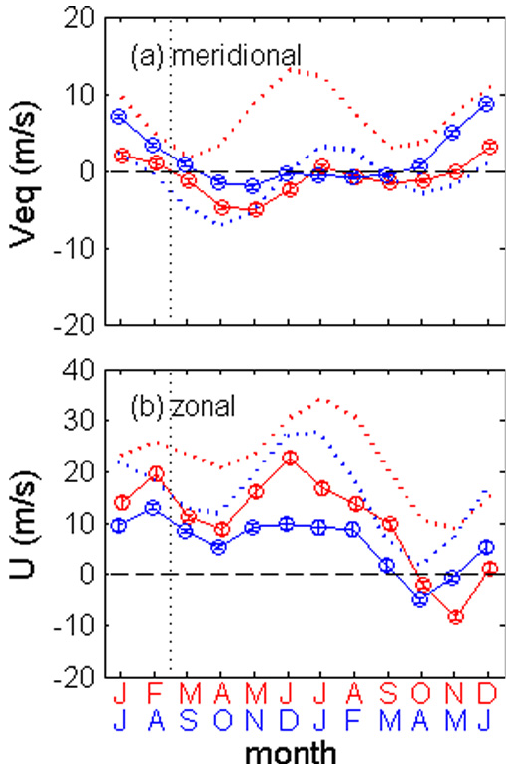
Fig. 10. As Fig. 9 but for the meridional, equatorward positive winds (a) and the zonal, eastward positive winds (b)